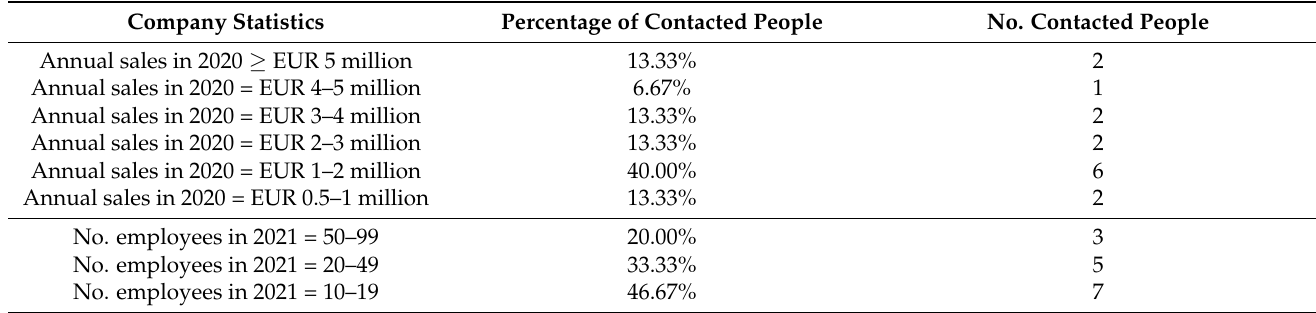
Table 3. Statistics of annual sales and number of employees of the companies where contacted people work. Company